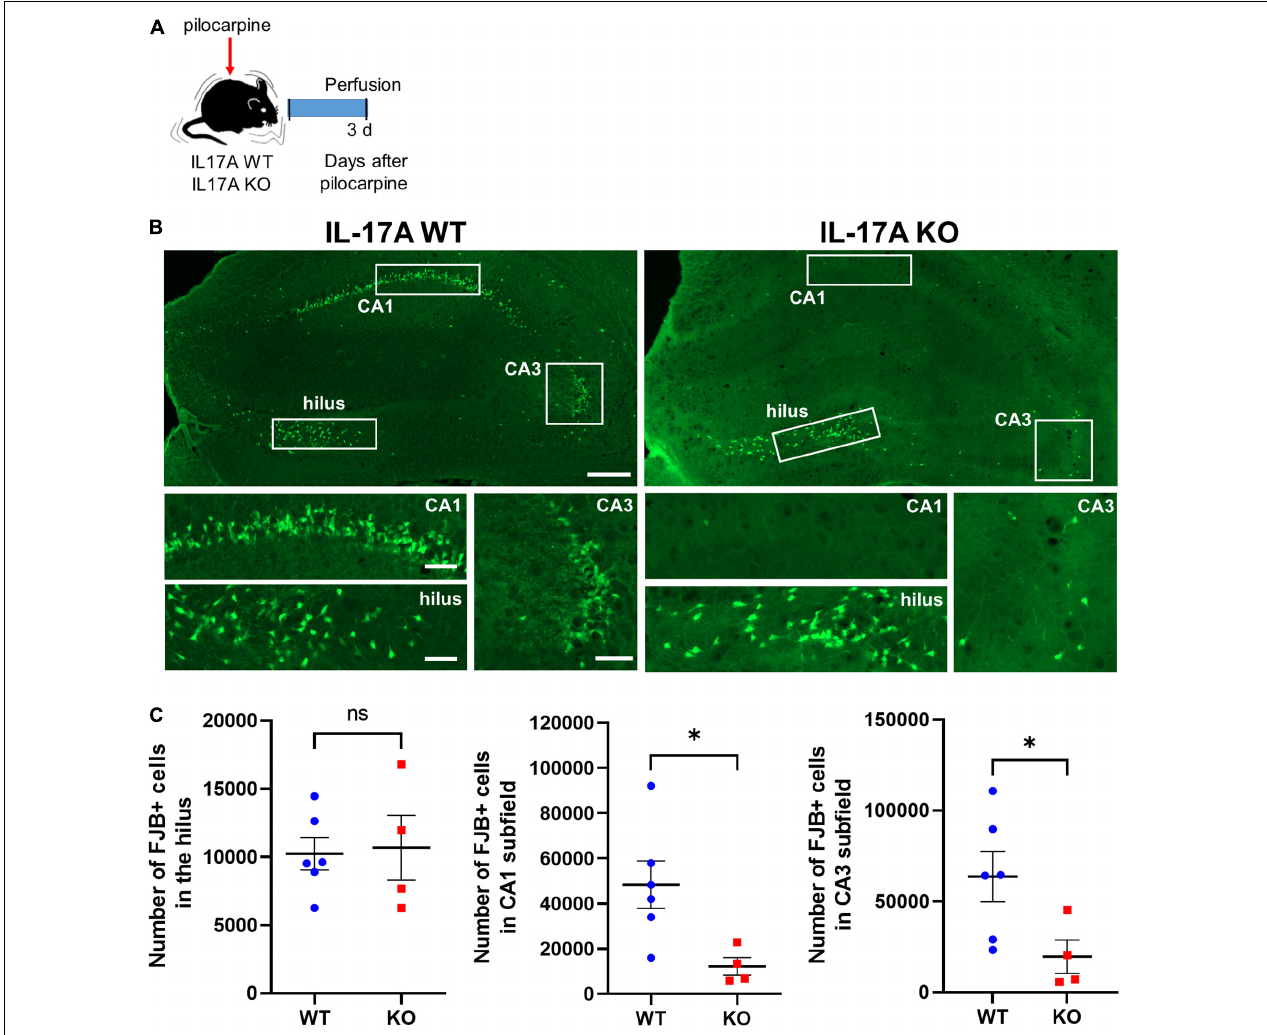
FIGURE 3 | IL-17A deficiency in mice promotes neuroprotection against pilocarpine-induced status epilepticus (SE). (A) Timeline showing the experimental design. (B) Representative microscope images showing degenerating neurons stained with Fluoro-Jade B (FJB). Magnified image areas in the hilus, CA1, and CA3 subfields are indicated as white rectangles. Scale bar = 200 µ m for low magnified images, 50 µ m for higher magnified images. (C) Graphs showing the number of FJB-positive cells in the hilus, CA1, and CA3 subfields of the hippocampus. Fewer degenerating neurons were observed in CA1 and CA3 subfields of the hippocampus in IL-17A KO mice compared with the WT group. n = 6 (WT) and n = 4 (KO). Detailed statistics are as follows. Hilus: Mann–Whitney U -test, p = 0.971, U = 11,500; CA1: Mann–Whitney U -test, p = 0.019, U = 1,000; CA3: Mann–Whitney U -test, p = 0.038, U = 2,000. Data are presented as mean ± SEM. ∗ p < 0.05, NS, not significant.